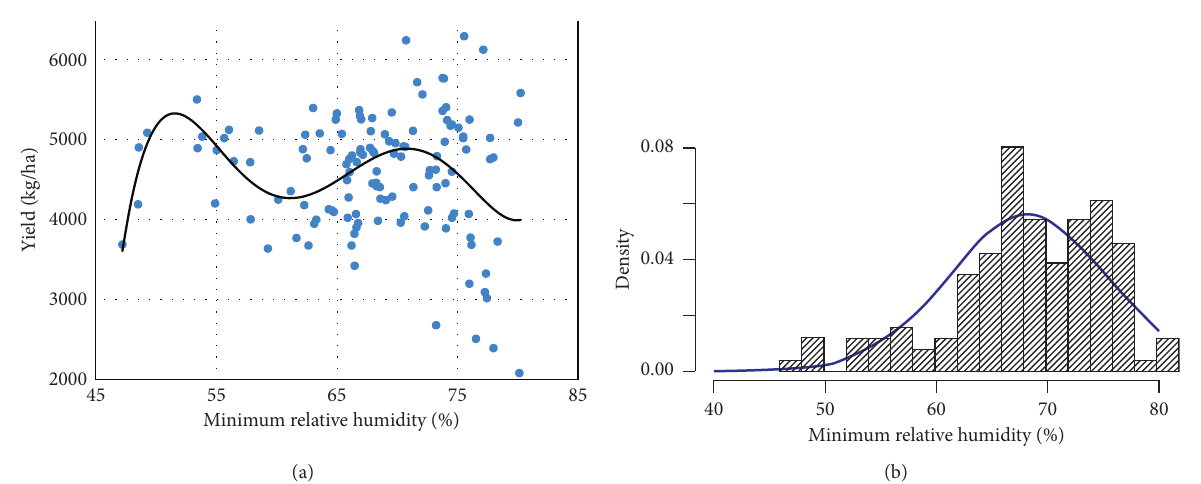
Figure 3: Distribution of minimum relative humidity data: (a) relationship with paddy yield and (b) data